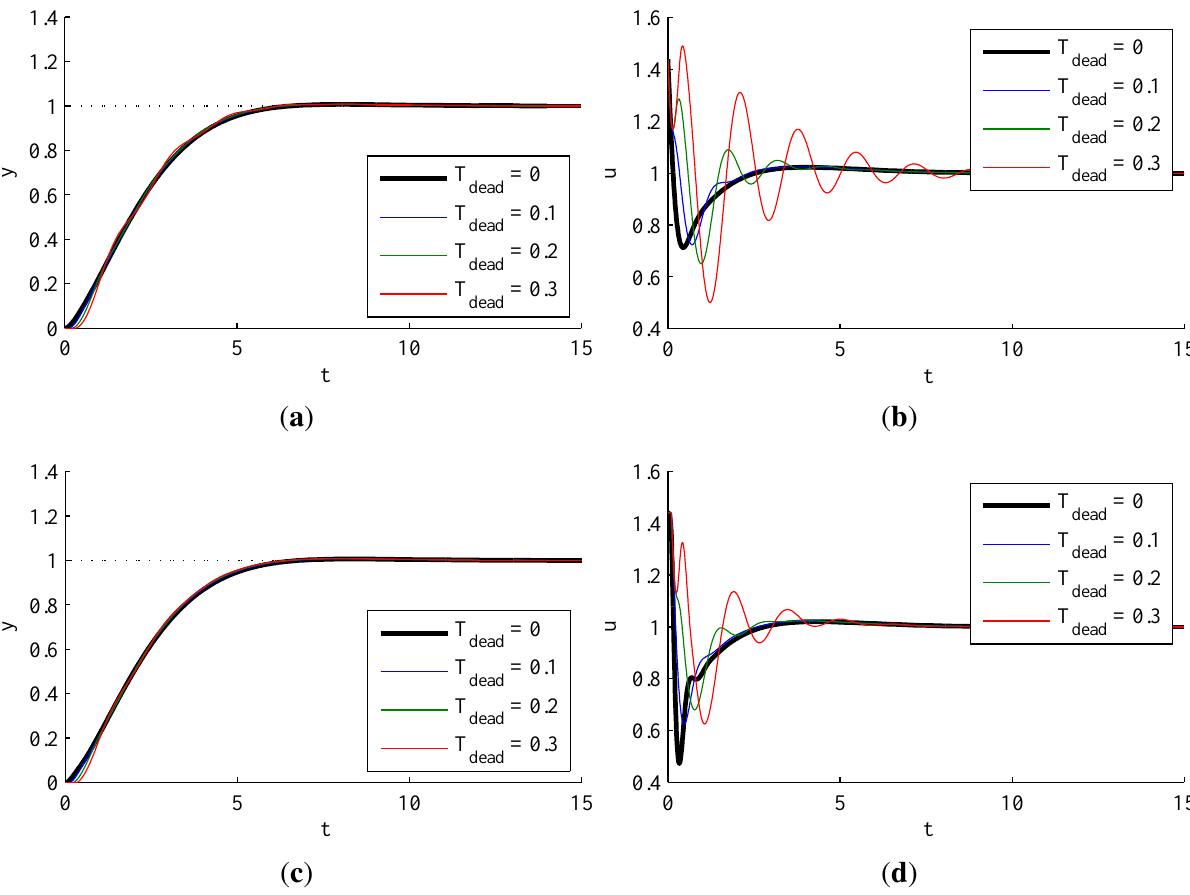
Figure 14. Experiment 3.2.4: effect of dead time, T , on a second-order ADRC controlling dead a process with second-order dynamics ( K = 1, D = 1, T = 1) and unknown dead time. ADRC = K = 1, T = 5, s ESO = 5 s CL . In ( c ) and ( d ), a fixed dead time, T ESO parameters: b 0 settle T 2 · was incorporated into the observer to improve the controller behavior. ( a ) Variation of T closed loop step response; ( b ) Controller output u for ( a ); ( c ) Closed loop step response, = 0 . 1; ( d ) Controller output u for ( a observer with T ESO dead